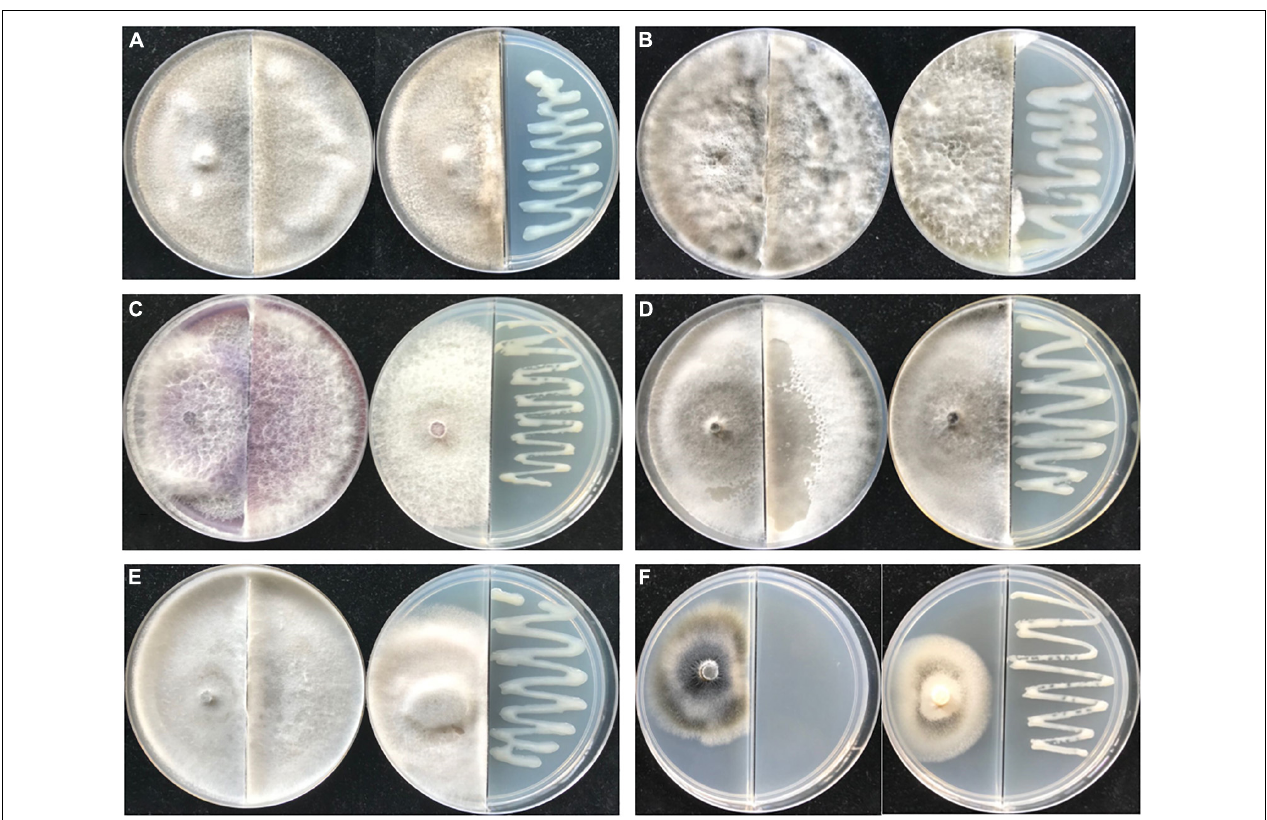
FIGURE 6 | The antifungal spectrum of Rahnella victoriana JZ-GX1 VOCs. Plate on the left untreated, plate on the right treated with VOCs. (A) Guignardia camelliae , (B) Fusicoccus aesculin , (C) Fusarium oxysporum , (D) Alternaria tenuissima , (E) Sphaeropsis sapinea , and (F) Verticillium dahlia .